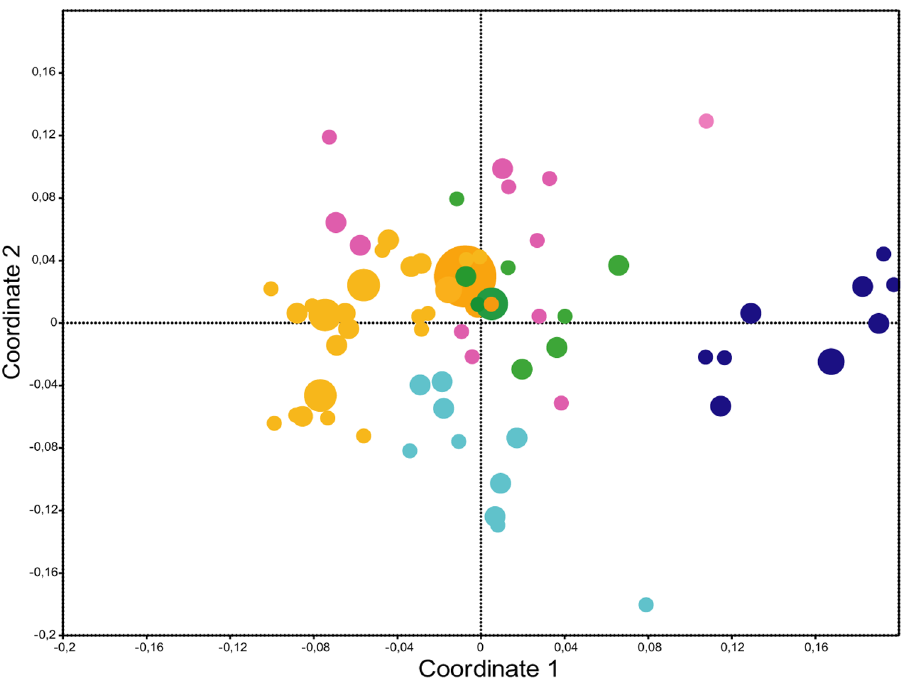
Figure 2. NMDS analysis of DGGE fingerprints. A Nonmetric Multidimensional Scaling plot (stress: 0.1986) of DGGE band presence/absence in technical and biological replicates of bacterial communities derived from the five plant lines is shown. Colour code: yellow: Ler wild type communities, pink: cer 1 communities, green: cer 6 communities, dark blue: cer 9 communities, light blue: cer 16 communities. Dot size represents number of replicates falling together on the same spot in the plot.